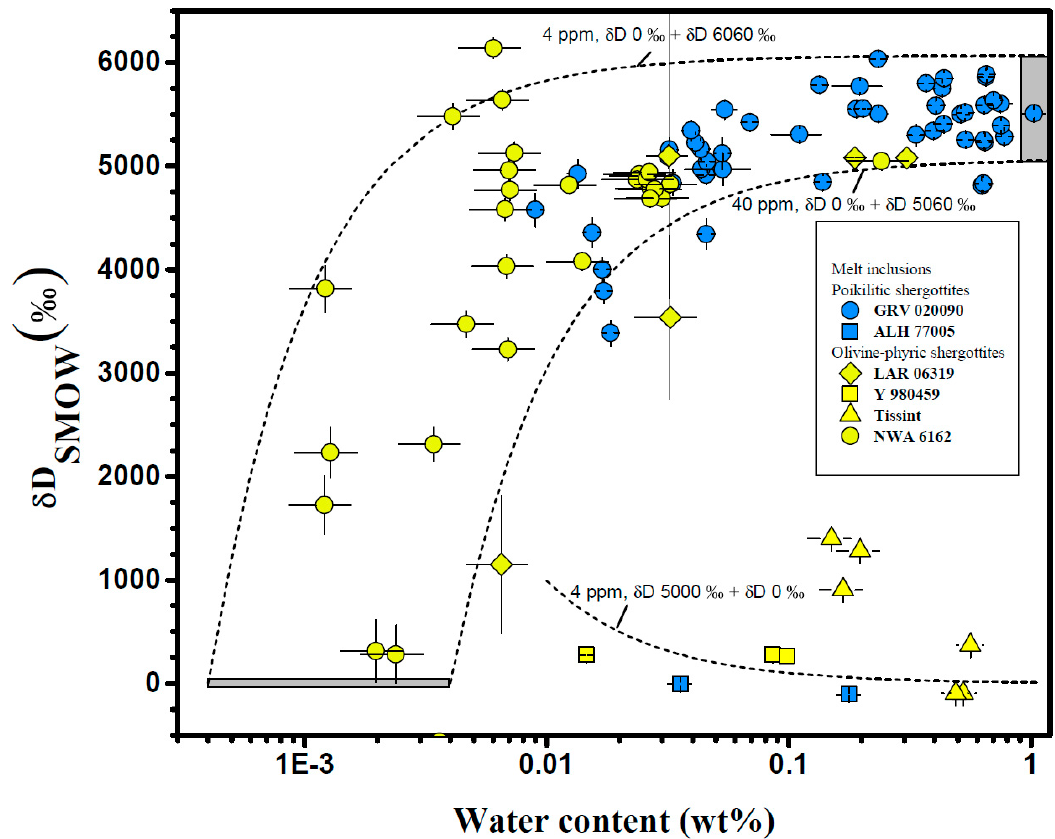
Figure 1. The relationship between water content and δ D values of melt inclusions from different shergottites. The dashed lines represent the mixing of the post-erupted water (H 2 O = 4–40 ppm and δ D ~ 0 ‰, lower left hatched area) and the Martian crustal water ( δ D = 6060–5060 ‰, upper right hatched area) from [68] . GRV 020090 from [67] , ALH 77005 from [59] , LAR 06319 from [53,69,72] , Y 980459 from [53,72] , Tissint from [52] , and NWA 6162 from [68] .